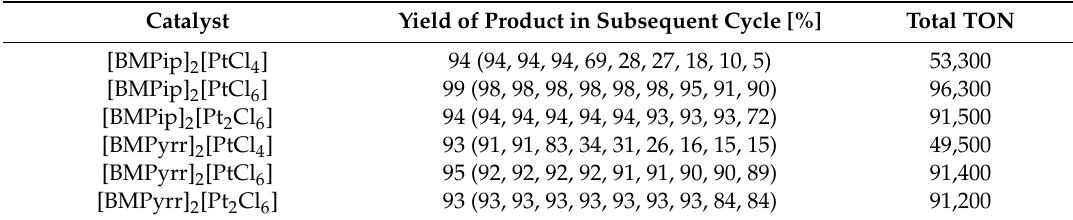
Table 5. Product yields and TON values for hydrosilylation of allyl glycidyl ether with HMTS, catalyzed by anionic platinum